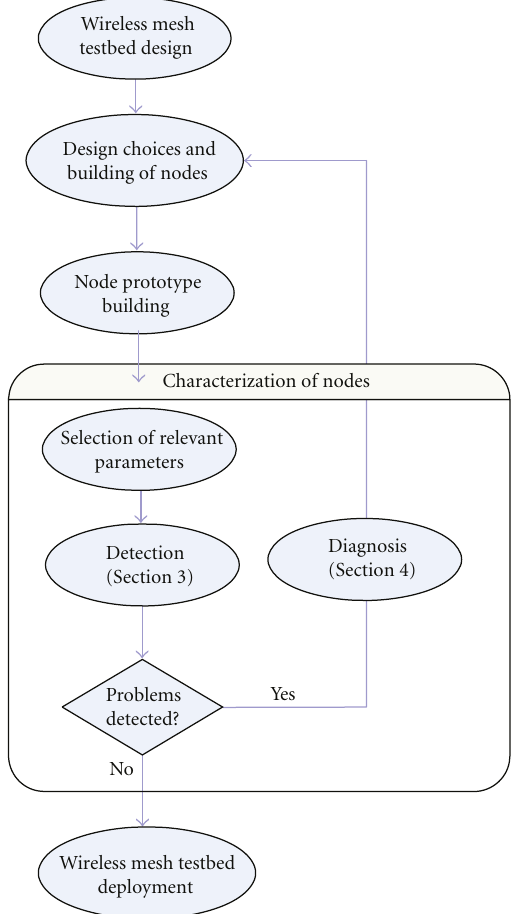
Figure 2: Consider a characterization step in your testbed design and implementation